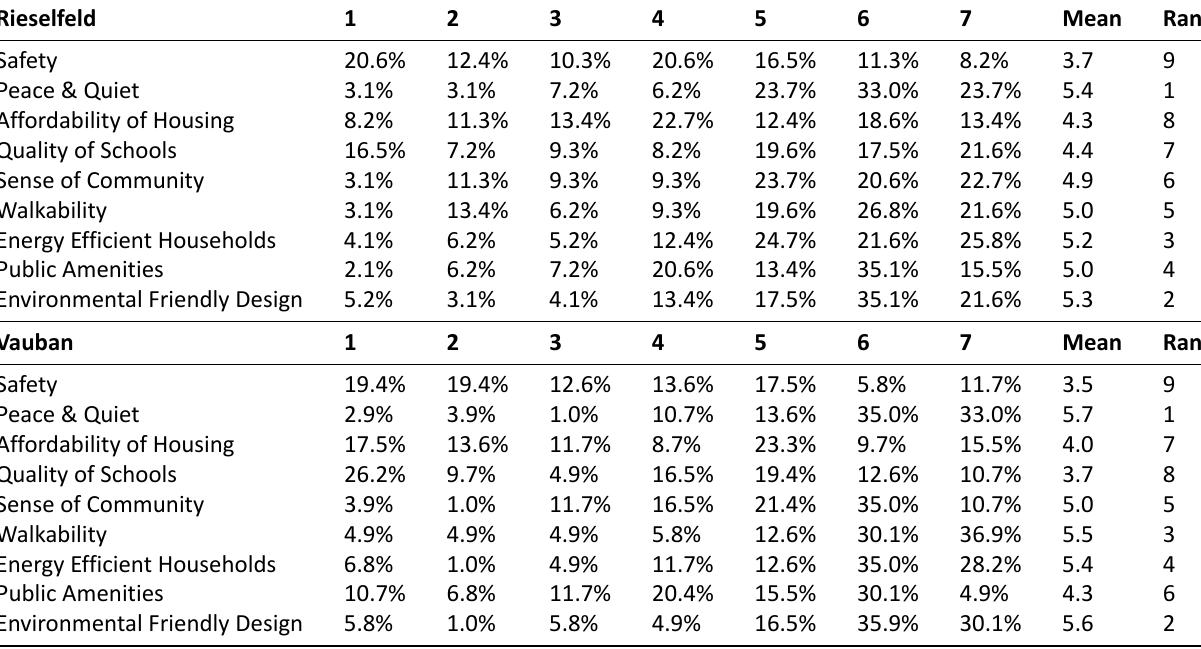
Table 3. Level of importance of different factors for moving to Rieselfeld or Vauban